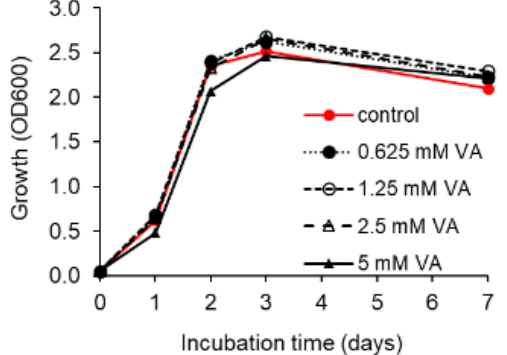
Figure 5. Effect of various concentrations of VA (vanillic acid) on growth (OD 600 ) of R. colostri DBVPG 10655 in complex medium at 10 °C (control = growth in R2A broth without VA) (mean values of three replicates; SDs ≤ 10%).